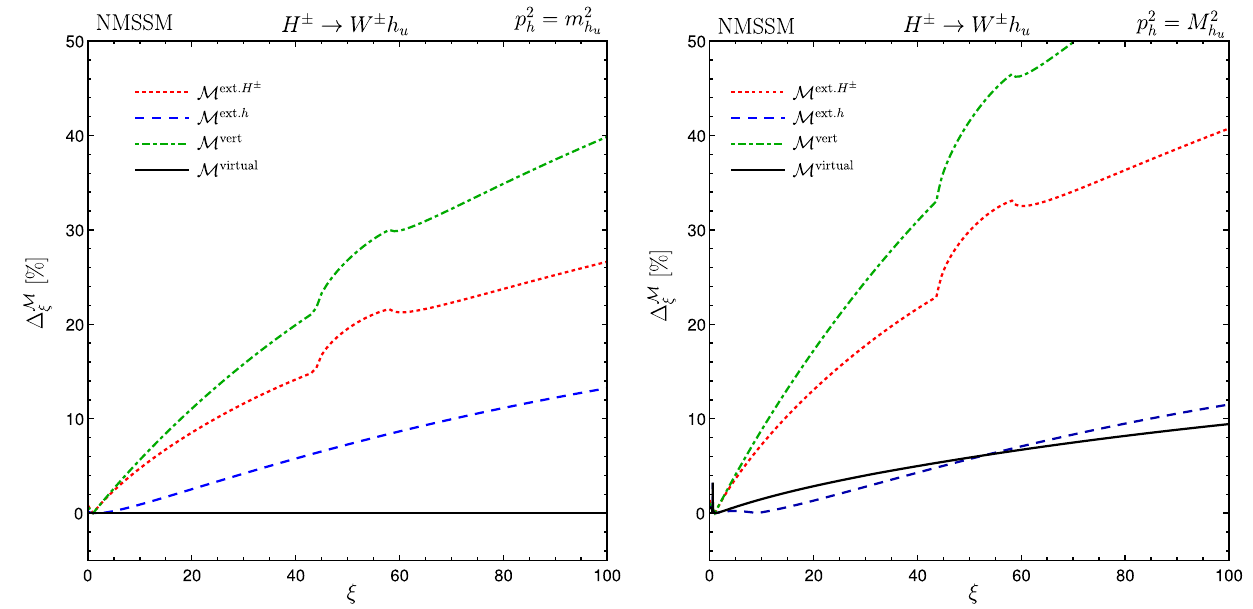
Fig. 8 Gauge dependence of the virtual electroweak corrections to H ± → W ± h u , with M ext , H ± (dotted, red), M ext , h (blue, dashed), M vert (green, dot-dashed) and M virt (black, solid). Left plot: Virtual